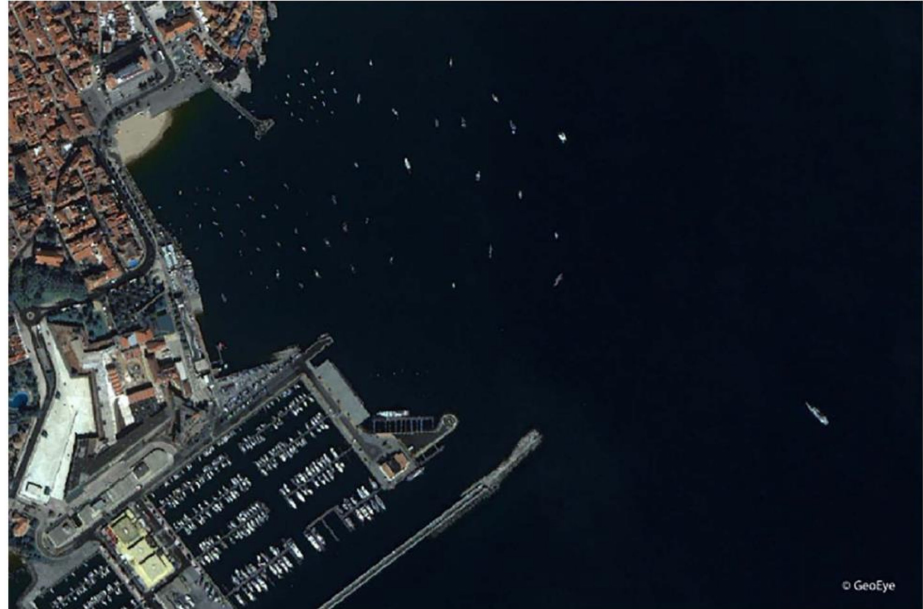
Figure 2. A GeoEye-1 optical image of Cascais in Portugal